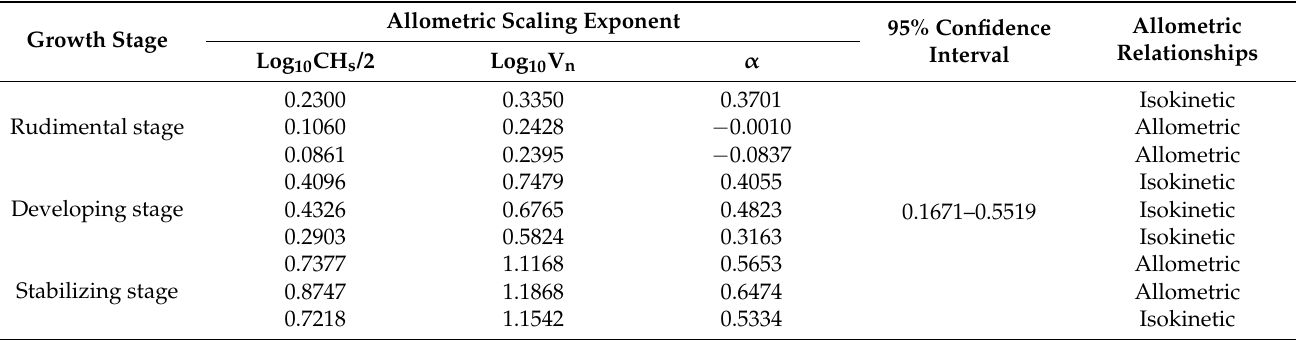
Table 2. The allometric relationships and coefficient by log 10 CH s /2 = log 10 β + α log 10 V d for the morphological characteristics of N. tangutorum and